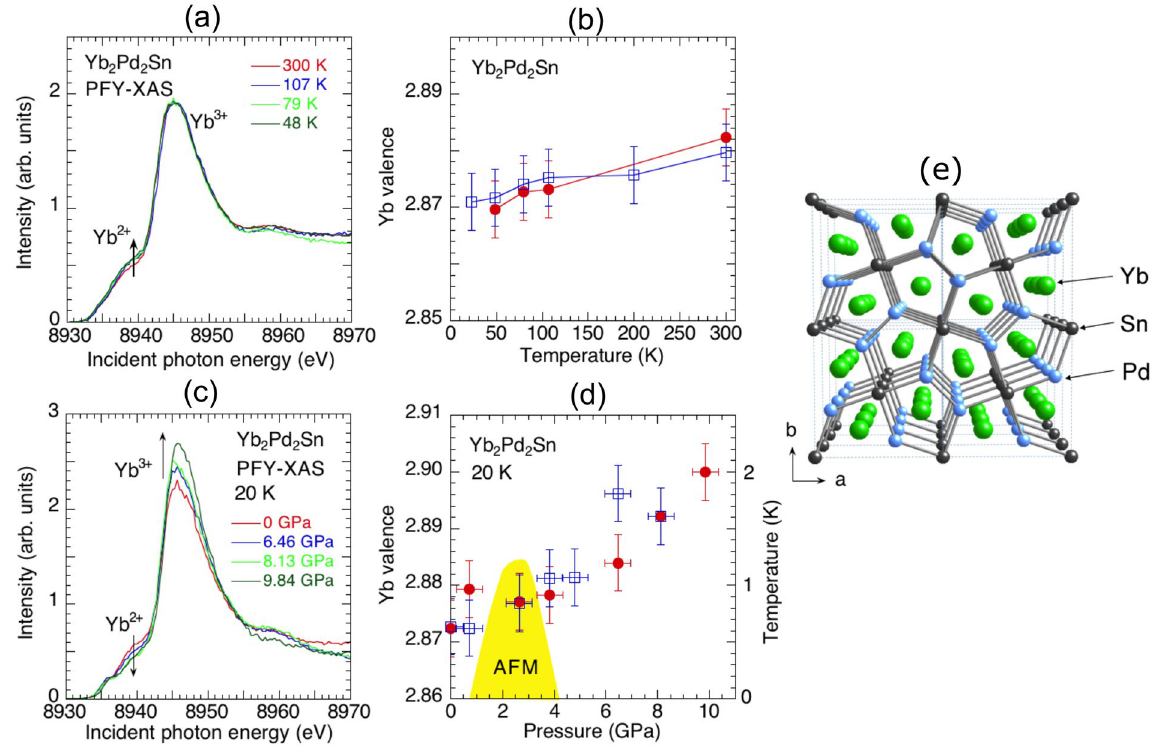
Figure 3. The experimental results of Yb 2 Pd 2 Sn are shown. ( a ) Temperature dependence of the PFY-XAS spectra at ambient pressure. Arrows in ( a ) correspond to the direction to decrease the temperature. ( b ) Temperature dependence of the Yb valence estimated from the fits to the PFY-XAS spectra (closed circle) and the RXES spectra (open square) at hv = 8938 eV. ( c ) Pressure dependence of the PFY-XAS spectra at 20 K. ( d ) Pressure dependence of the Yb valence estimated from the fits to the PFY-XAS spectra (closed circle) and the RXES spectra (open square). In ( d ) we also show the pressure dependence of the Néel temperature as a yellow- colored area, where the data are taken from the literature 16 . ( e ) Crystal structure of Yb 2 Pd 2